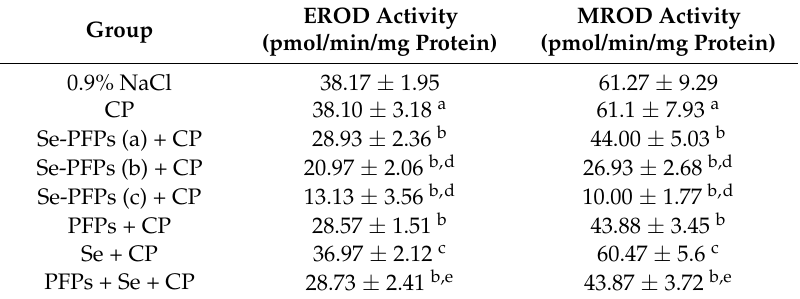
Table 5. Activities of CYP1A and CYP2A in the liver of mice after various treatments ( n = 10). EROD Activity Group (pmol/min/mg